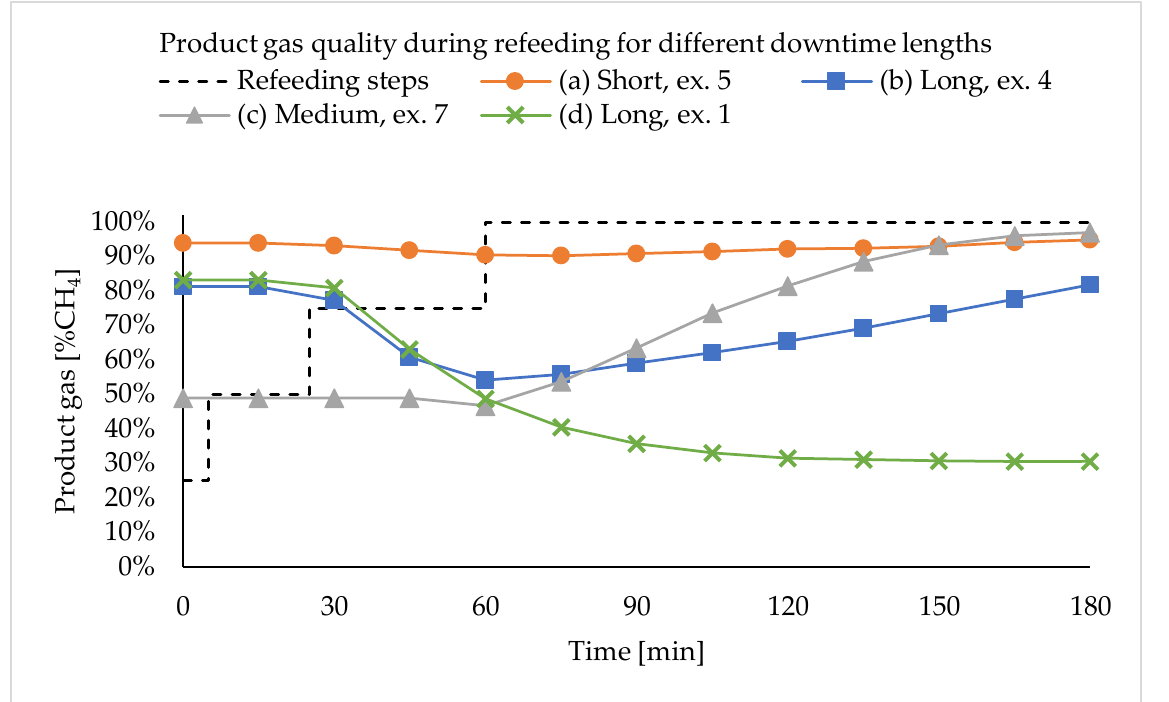
Figure 3. Examples of the drop-, lag phase-, and decrease-tendency observed of product gas quality after start of refeeding. Illustrating the effect of the parameters set during downtime have on the product gas after refeed initiation. Each line represents an experiment for a certain downtime length.